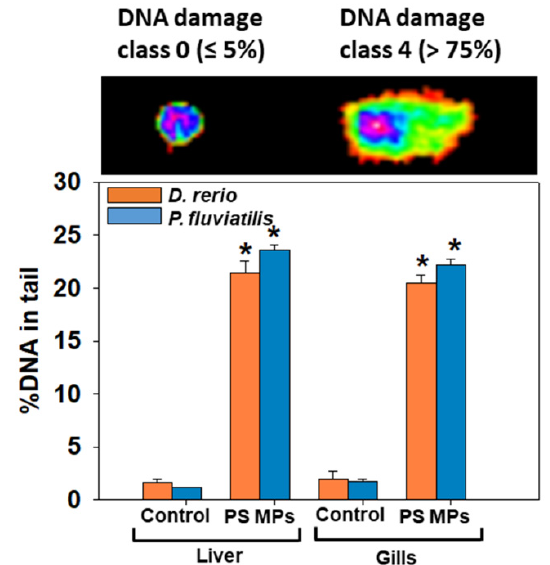
Figure 6. Percentage (%) of DNA damage (mean ± SD) in tail in liver and gills of Danio rerio ( n = 3 pools of 10 individuals) and Perca fluviatilis ( n = 6). Six slides per pool (zebrafish) and six slides per individual (perch) were measured, in order to represent technical replicates. Randomly selected 100 cells were scored from each slide (TritekCometscoreTM 1.5, TriTek Corporation, Wilmington, DE, USA). Representative pictures of DNA damage are shown. Mann–Whitney U test was employed to test for significance at p < 0.05 between all experimental groups. * denotes significant differences ( p < 0.05) compared to the control group ( n = 3 pools of 10 individuals and n = 6 for D. rerio and P. fluviatilis respectively). %DNA in tail and Olive moment in positive control data (1 μΜ H 2 O 2 ) were 28.3 ± 5.2 and 40 ± 6.3, respectively.